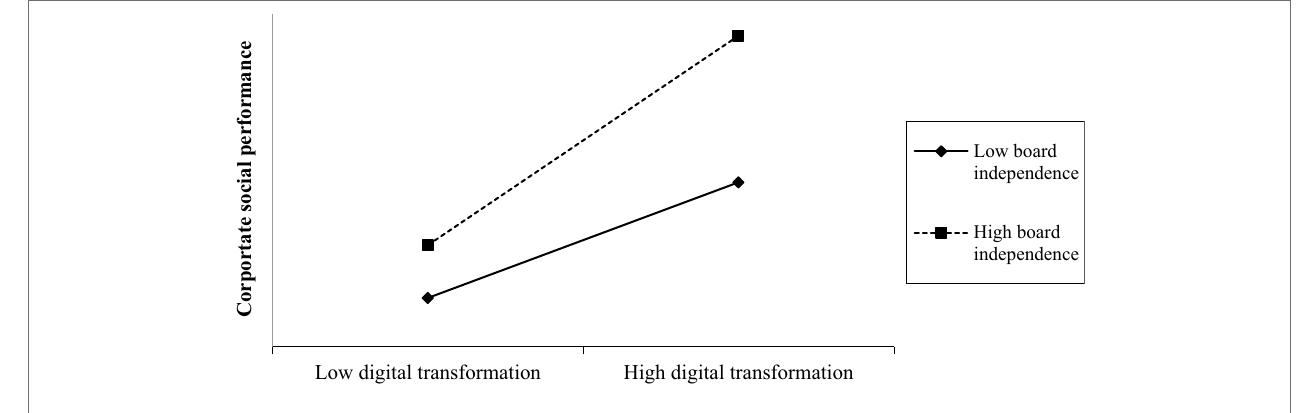
FIGURE 2 | Moderating effect of board